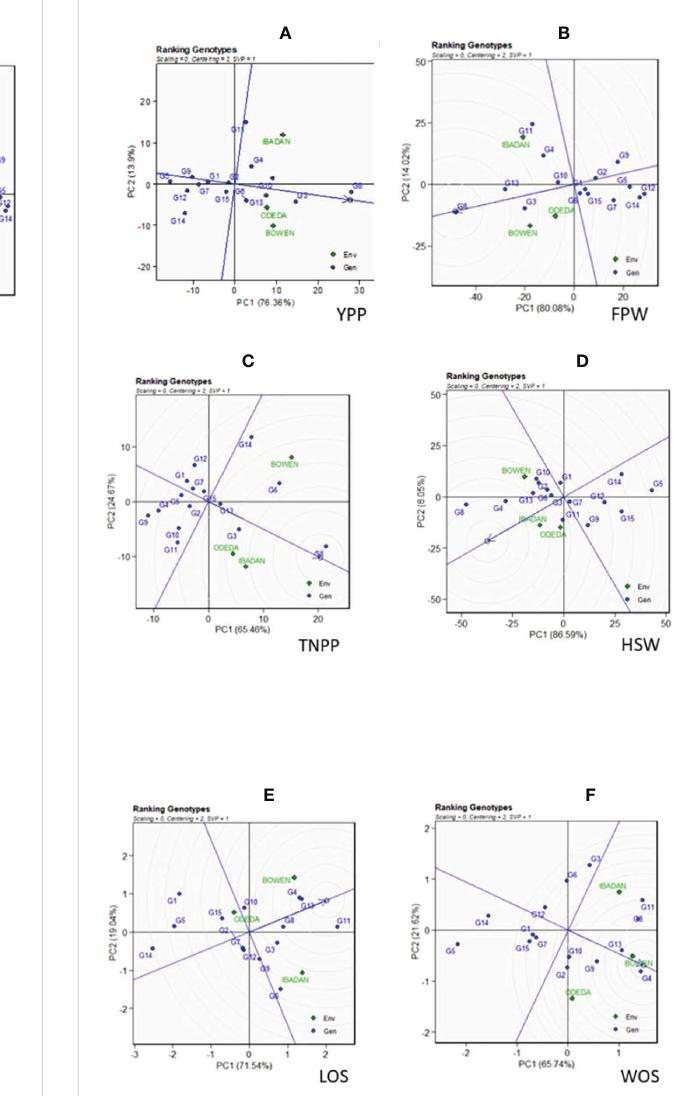
FIGURE 4 Patterns (A – F) . Ranking genotypes based on PC1 and PC2 showing G × E interactions of the 15 Bambara groundnut accessions under three sites: (A) yield per plant (YPP), (B) fresh pod weight (FPW), (C) total no. of pods per plant (TNPP), (D) hundred seed weight (HSW), (E) length of seeds (LOS), and (F) width of seeds (WOS). The ranking genotypes were based on scaling = 0, centering = 2, and singular value partitioning (SVP) =